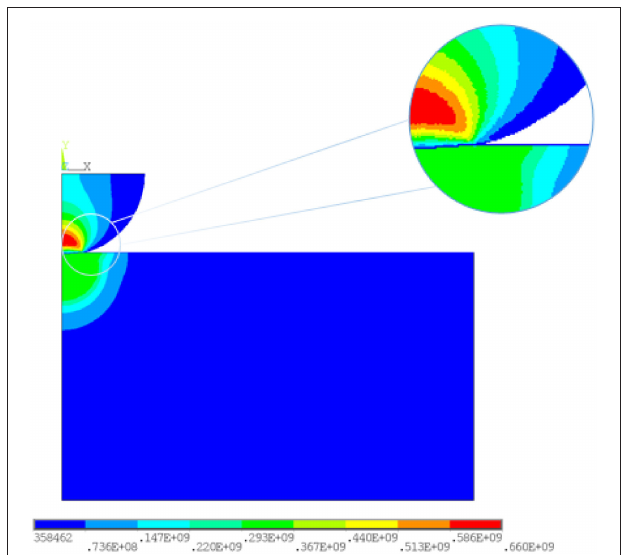
FIGURE 3 | Variation of flat deformation ratio with respect to the strain hardening and applied displacement for material set 1 (numerical